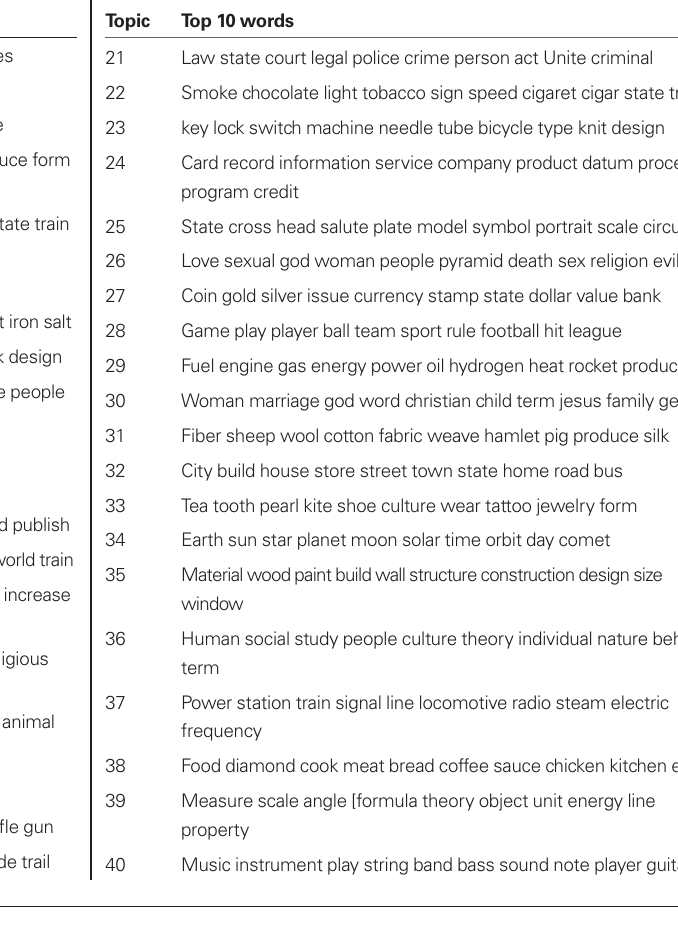
Table 1 | The top 10 most probable words according to each topic in the 40 topic model used in Figure 2A (topic ordering is slightly